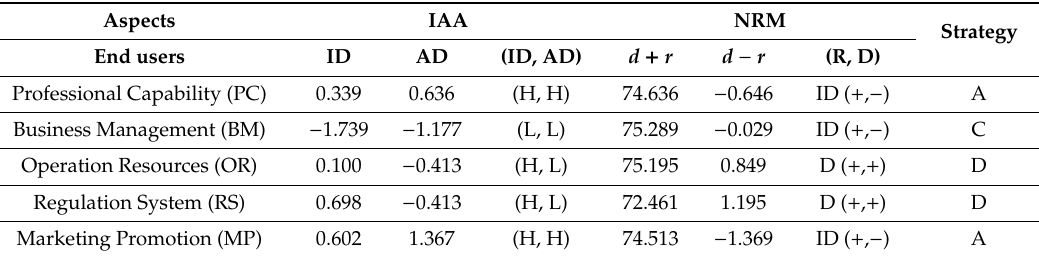
Table 15. The development strategy for end users.